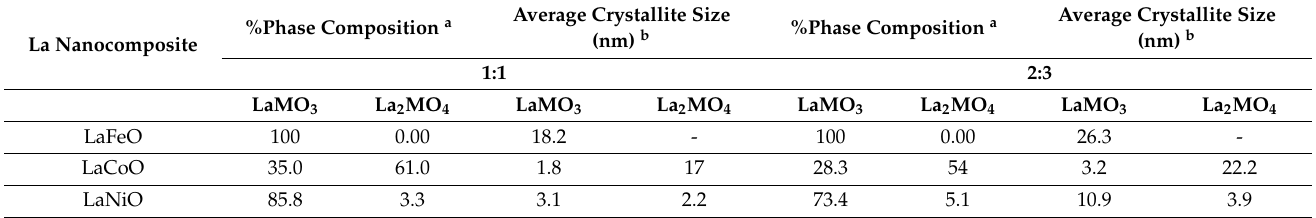
Table 1. Phase composition and the average crystallite size of La